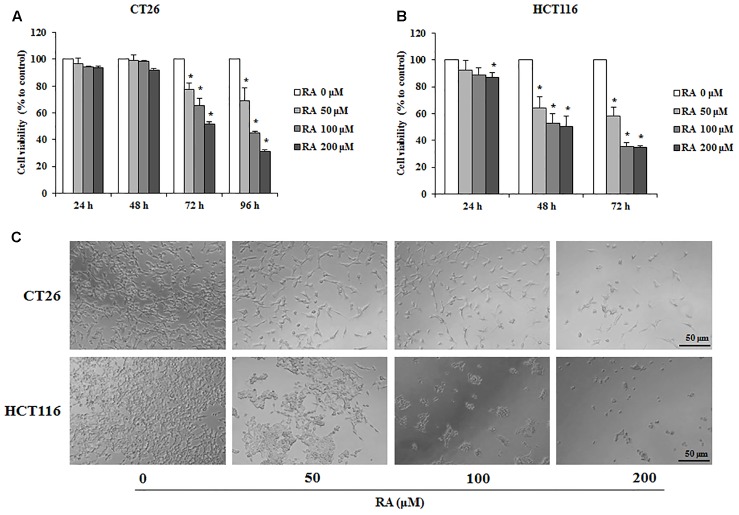
Rosmarinic acid (RA) exhibits an anti-proliferative effect on metastatic CRC cells. (A,B) The cell viability of RA-treated CT26 (A) and HCT116 (B) cells. The cells were seeded at a density of 3 × 103 cells/well in 96-well microplates and treated with RA for 24, 48, 72, and 96 h. After treatment with RA, cell viability was measured by using the MTS assay. (C) The morphologies of CT26 and HCT116 cells treated with RA for 96 h and 72 h, respectively. The images were obtained by using a microscope (200× magnification). The results are expressed as the mean ± SD. ∗p < 0.05 indicates a significant difference from the untreated group.